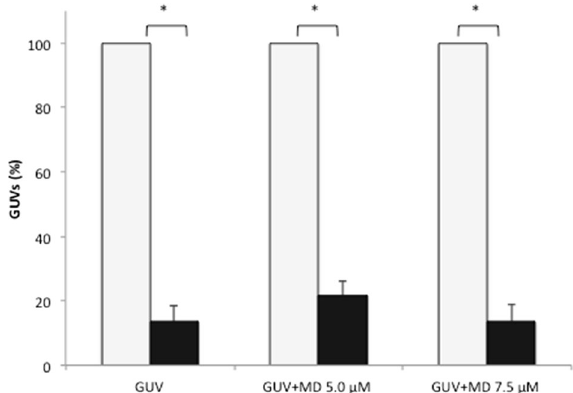
Figure 4. Percentage of giant unilamellar vesicles (GUVs) present in droplets of in vitro cultured bovine embryos. The percentage of GUVs on the last day of culture (D7: black bars) was determined in relation to the total number of GUVs present on the first day (D1: light gray bars). On D6, oxidative stress was induced in the embryos by the addition of different concentrations of menadione (MD) for 24 h. There was no significant difference between treatments at each time point ( P > 0.05). The asterisk indicates a significant difference within the same treatment when evaluated on different days ( P <